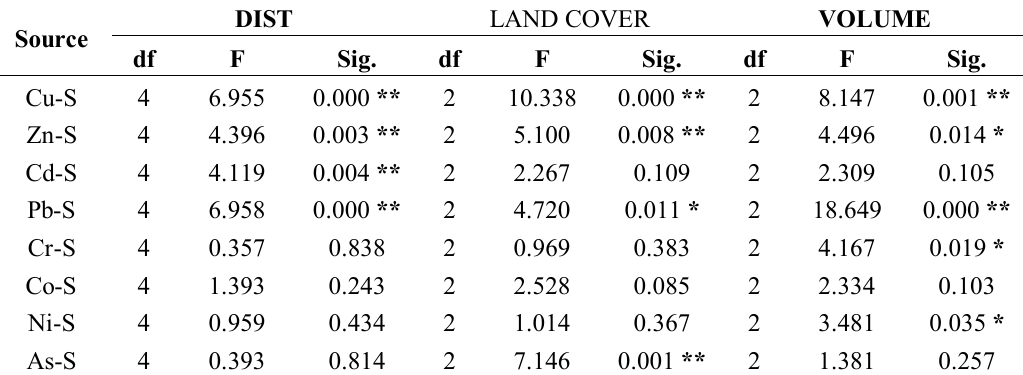
Table 6. MANOVA results of trace element concentrations for Soil Samples.